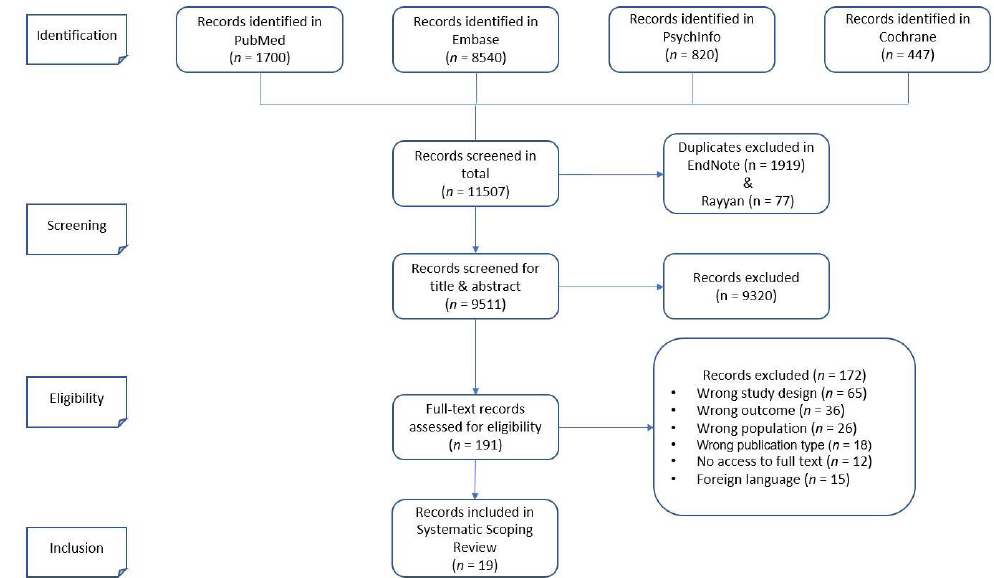
Figure 1. Prisma flow diagram of study screening and inclusion.